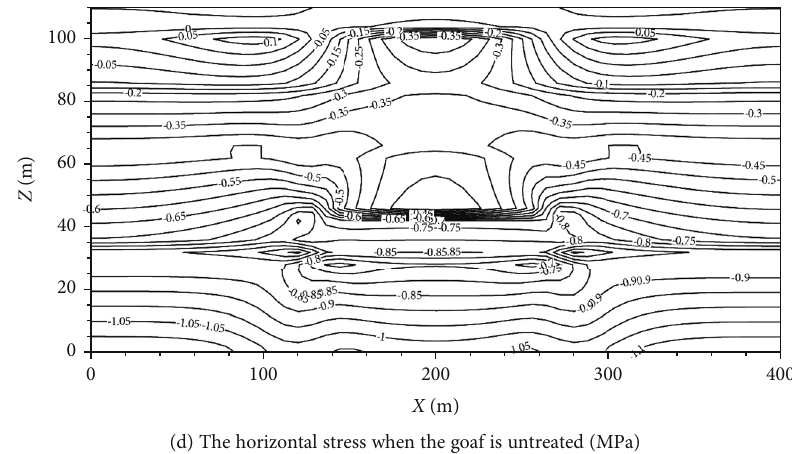
Figure 5: Displacement stress distribution diagram of goaf without